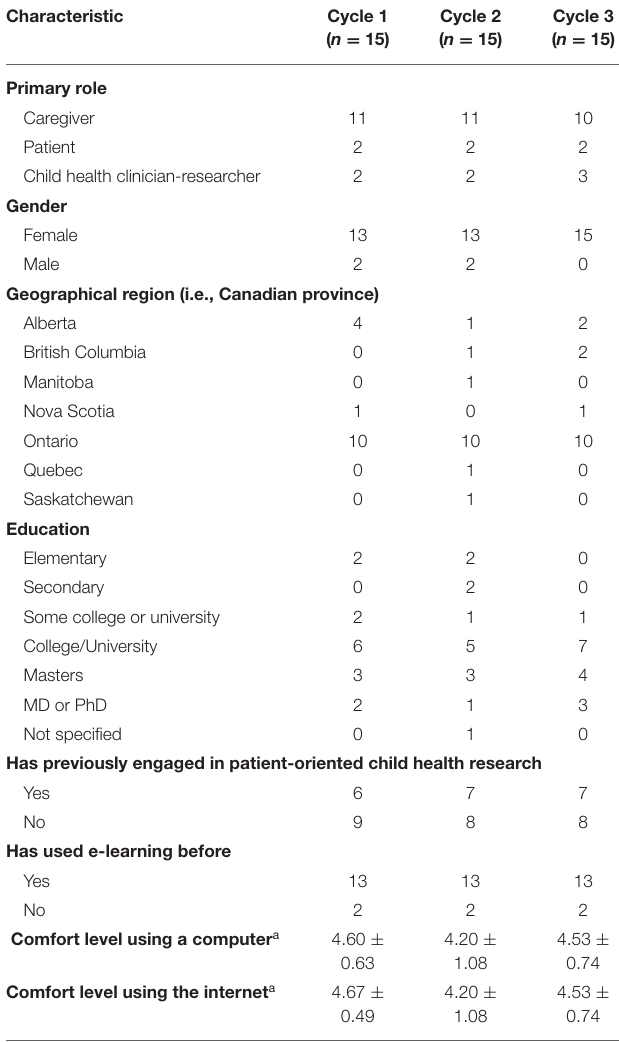
TABLE 1 | Participant